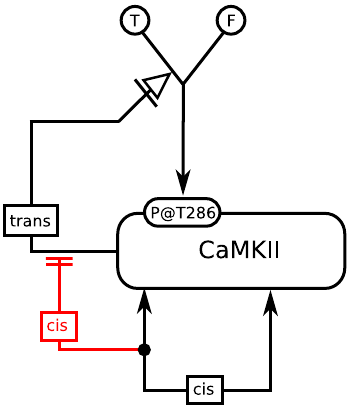
Figure 2.28: This example shows how an intra-molecular interaction of CaMKII precludes totally its catalytic activity upon another molecule of